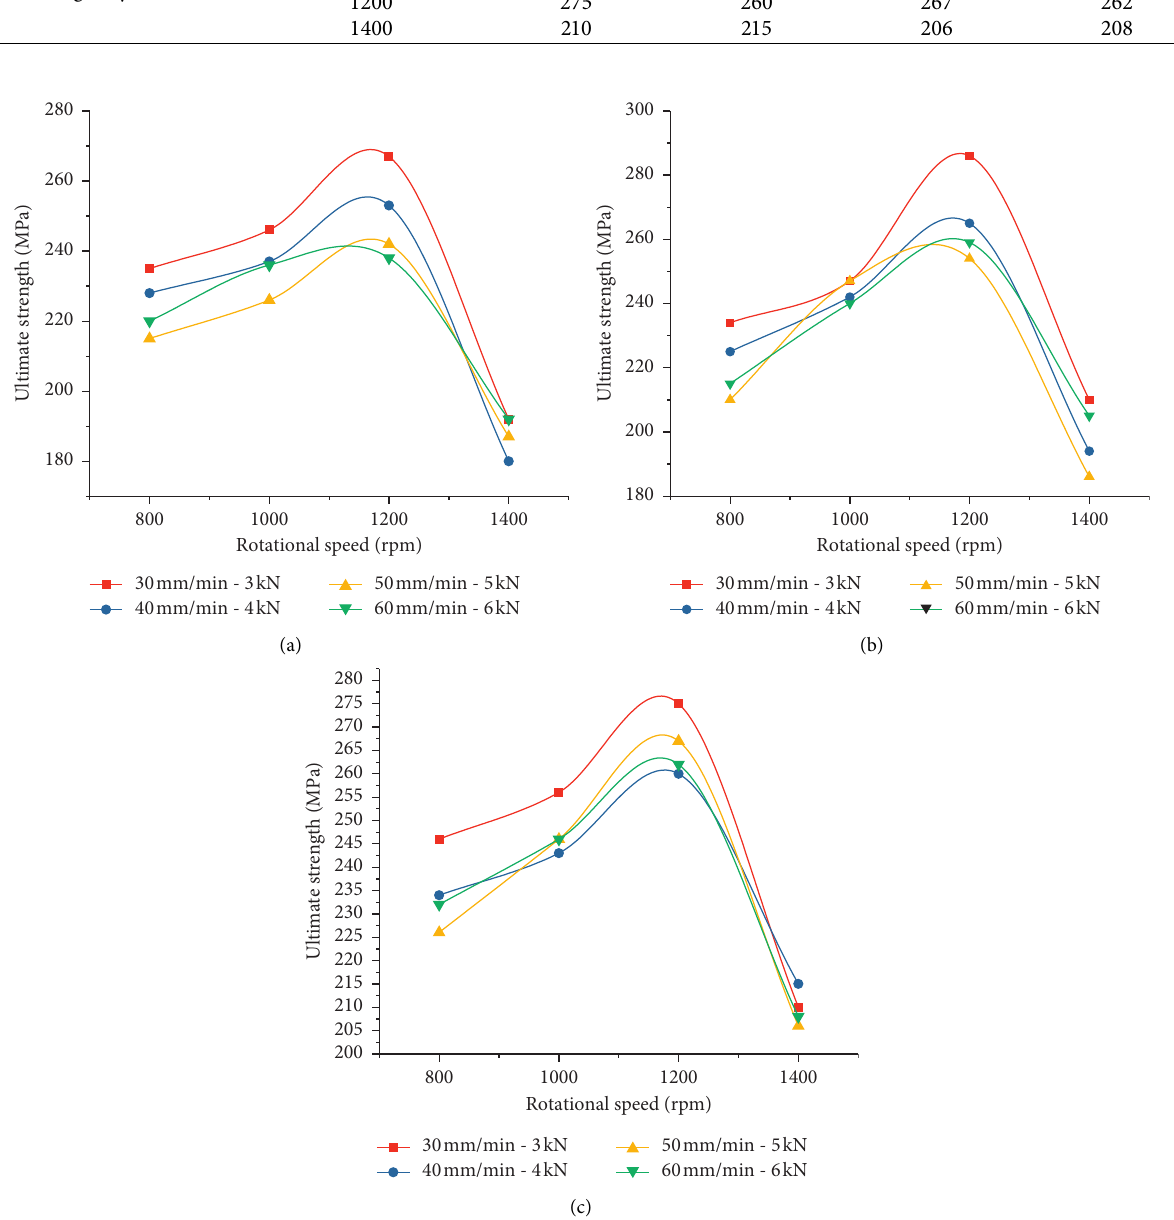
Figure 2: (a) Rotational speed vs. ultimate tensile strength (cylindrical taper tool), (b) Rotational speed vs. ultimate tensile strength (triangular tool), and (c) Rotational speed vs. ultimate tensile strength (straight cylindrical